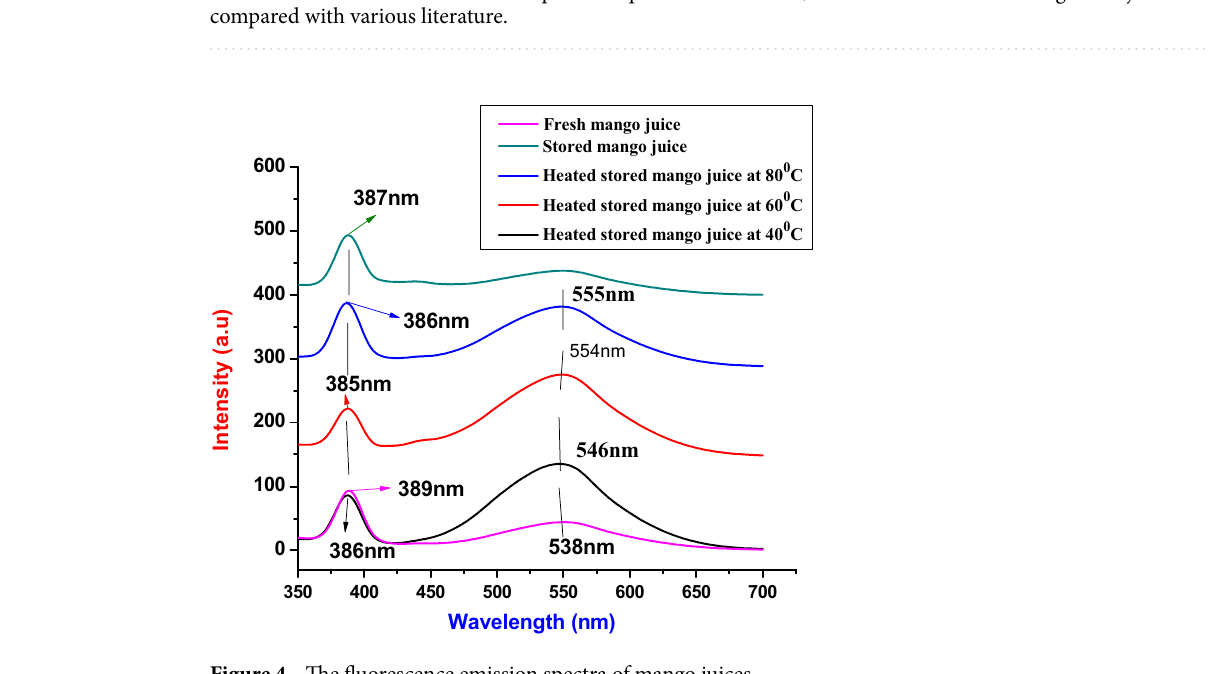
Figure 4. The fluorescence emission spectra of mango